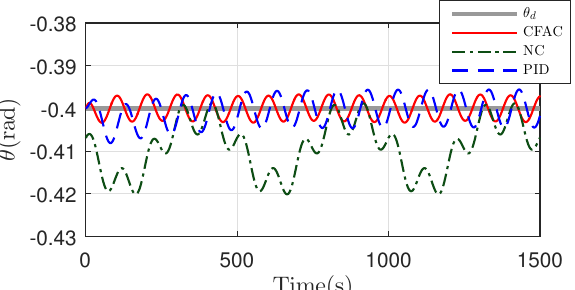
Figure 6. Pitch angle tracking performance in submerging motion with a variable velocity and constant pitch angle command.